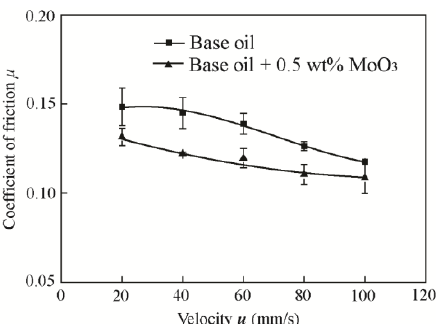
Figure 10. Friction coefficients of base oil and with 0.5 wt % micro-lamellar MoO 3 additives under different velocities.